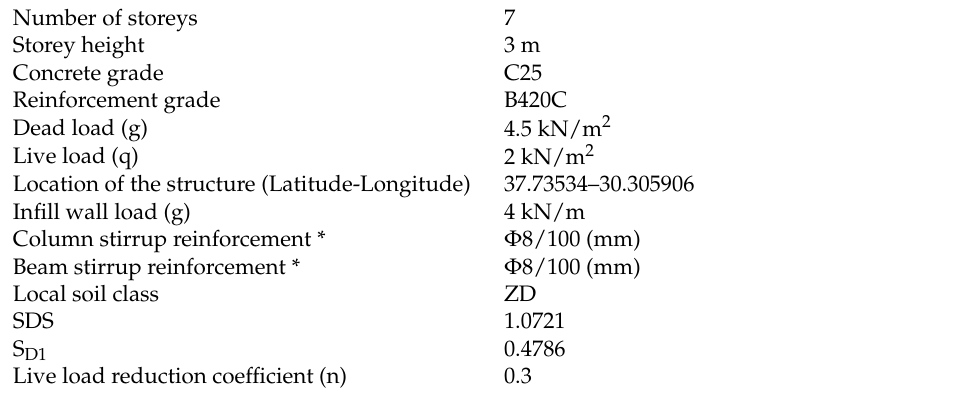
Table 1. Sample RC model features.